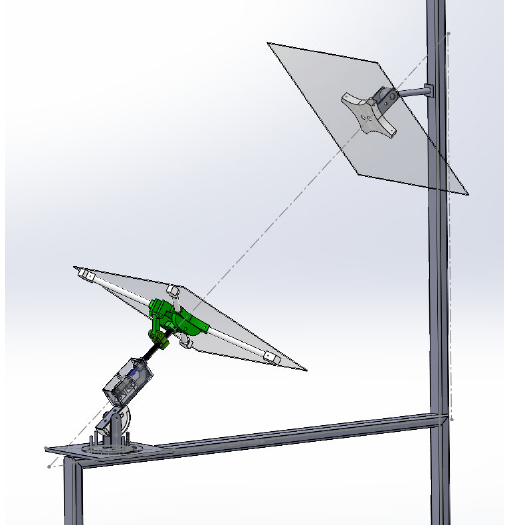
Figure 11. Device designed for mounting the proposed heliostatic illuminator.